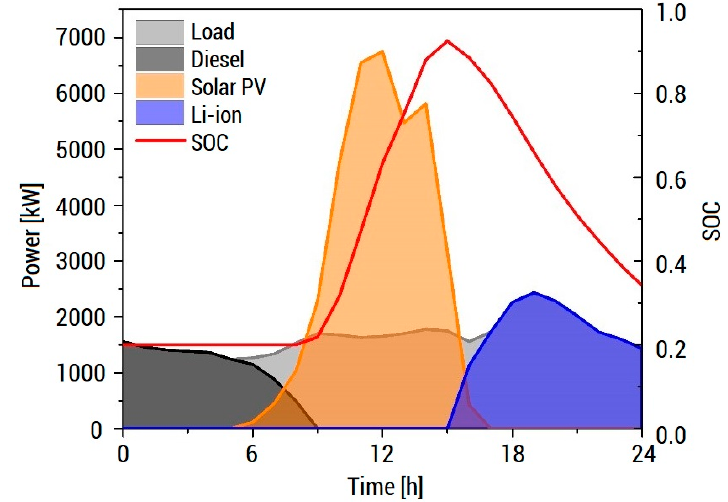
Figure 9. Power flow of the more reliable HRES without disturbances.